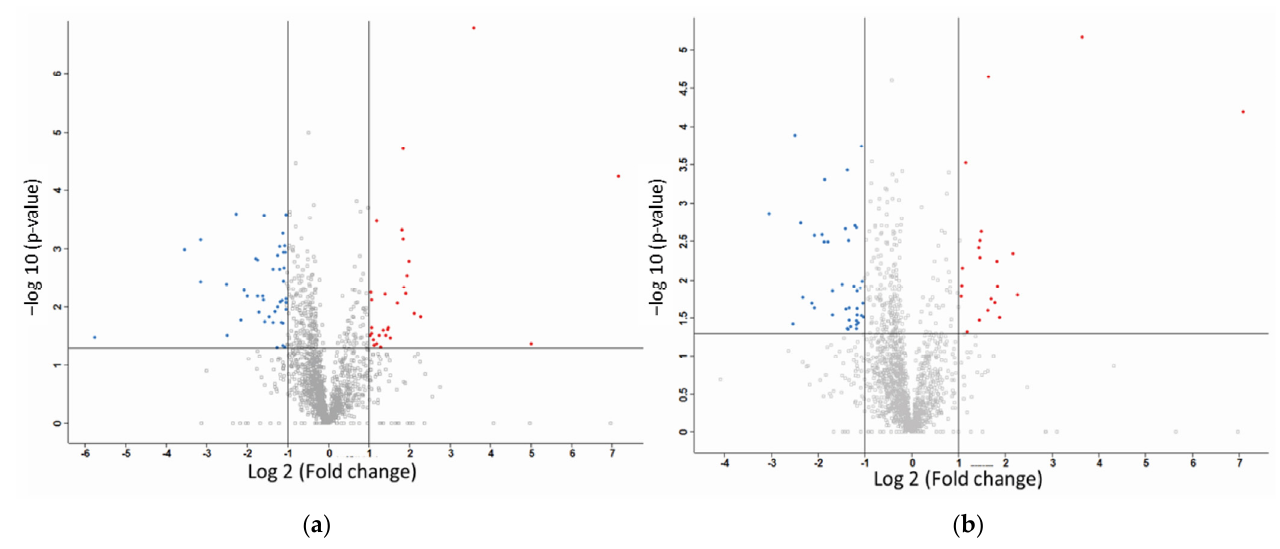
Figure 2. Volcano plots showing the variation in log10 ( p value) with log2 (fold change) for various pairwise comparisons: ( a ) CuHL1 vs. Control and ( b ) CuHL2 vs. Control. Color map: grey: not significant, red: up-regulated, blue: down-regulated. Table 1. Differentially expressed proteins in CuHL1-treated MDA-MB.231